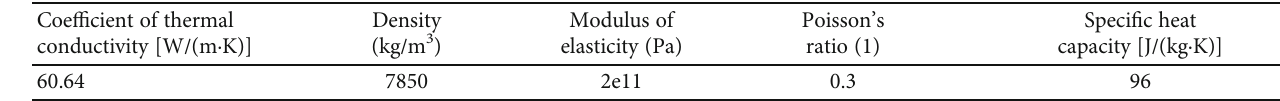
Figure 3: The comparative error analysis for the two kinds of fi tting: (a) ice cylinder, (b) ice circular truncated cone, and (c) ice ball. Table 2: Typical parameters for the thermotank wall.